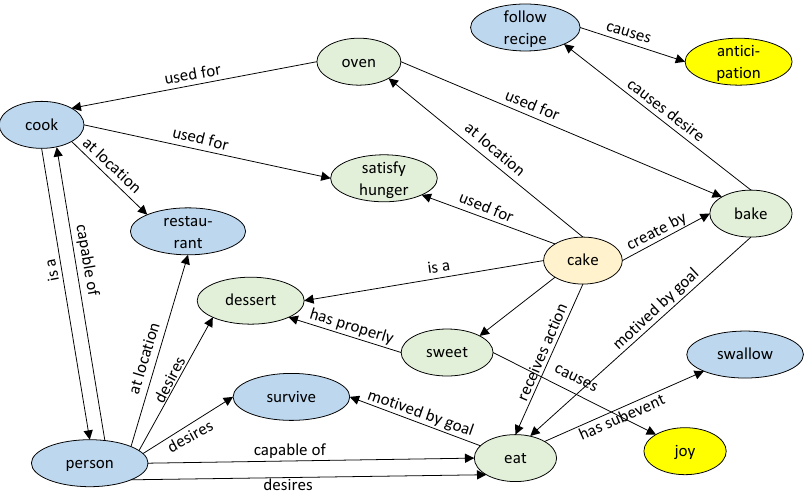
Figure 2. A sketch of the SenticNet graph showing part of the semantic network and sentiment for